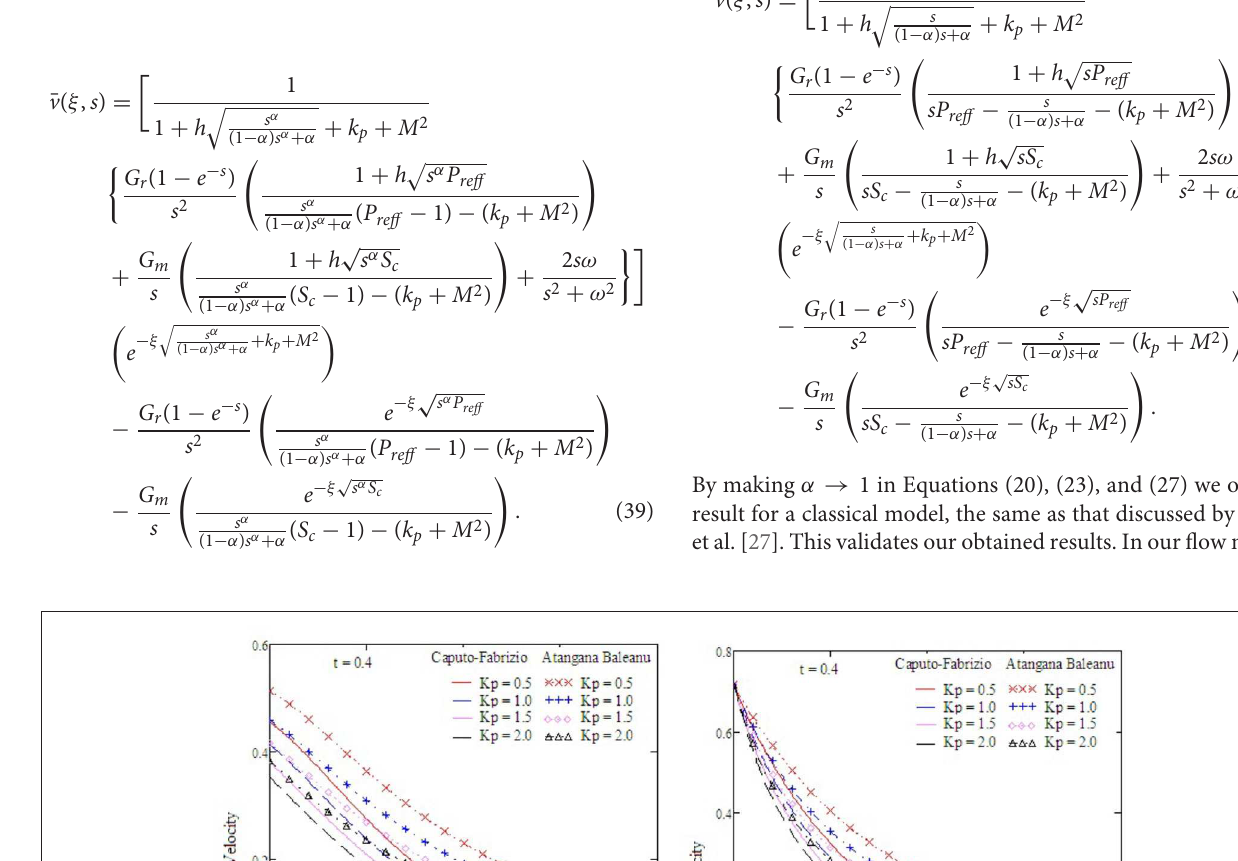
Frontiers in Physics |